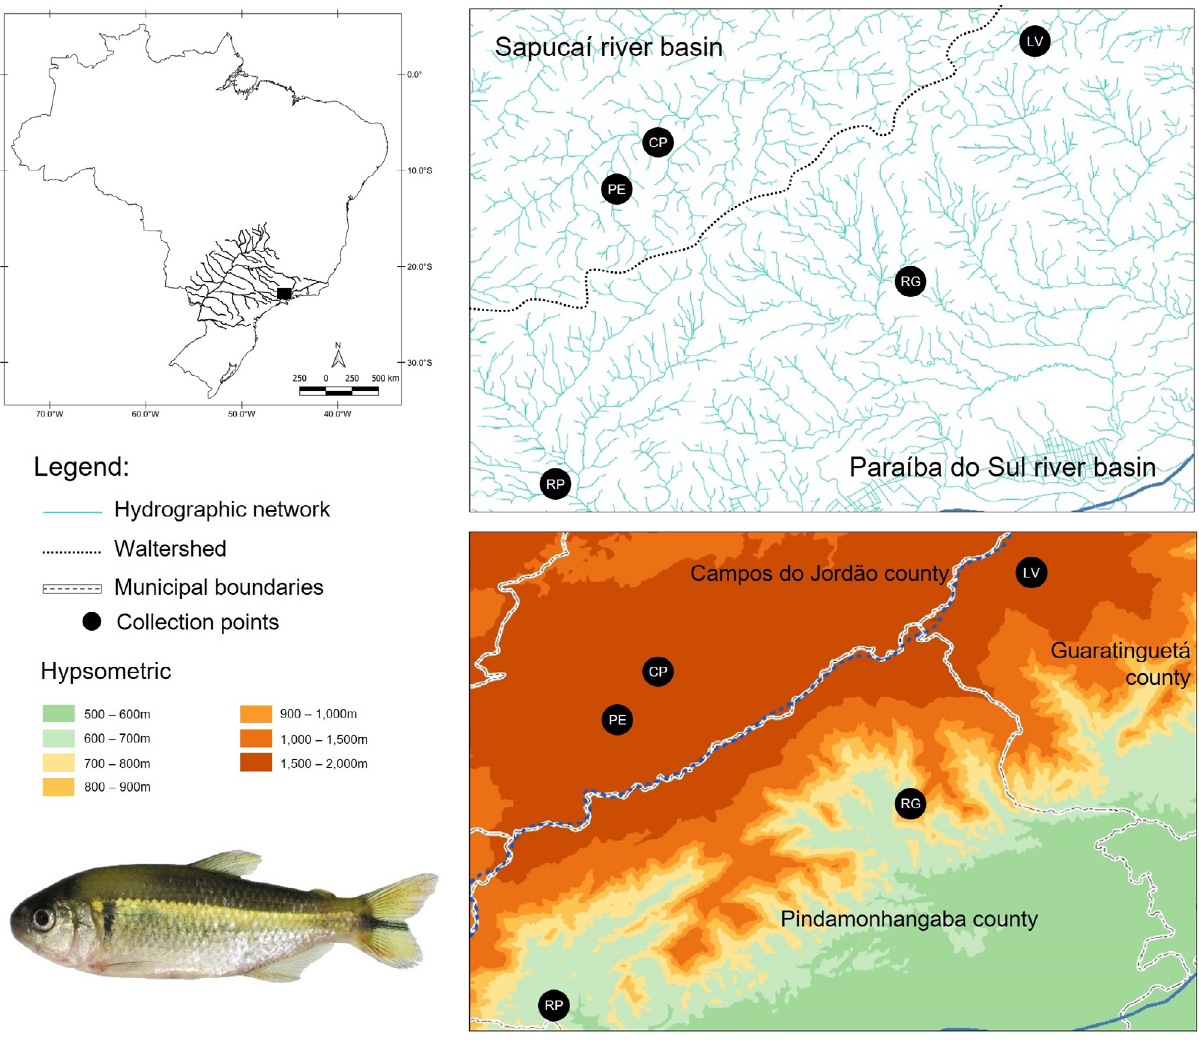
Figure 1 – Collection sites for the examples of Psalidodon scabripinnis . Above and to the left, the Paraná River and Paraíba do Sul River basins; the black dot represents the collection area. Below and to the left, a specimen of Psalidodon scabripinnis . Above and to the right, approximation to the collection points and the hydrographic network; below and to the right, approximation of the collection sites, showing the altitude of each